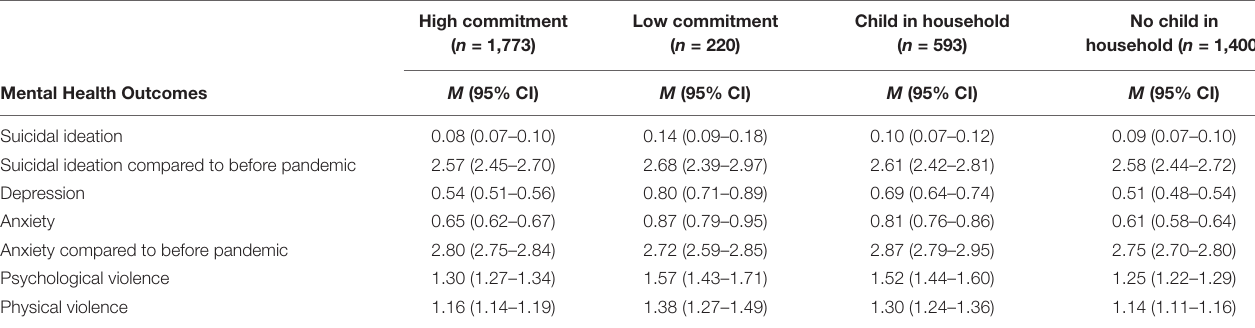
TABLE 3 | Mental health among participants with relationships stratified by relationship commitment and family structure ( n = 1,993).